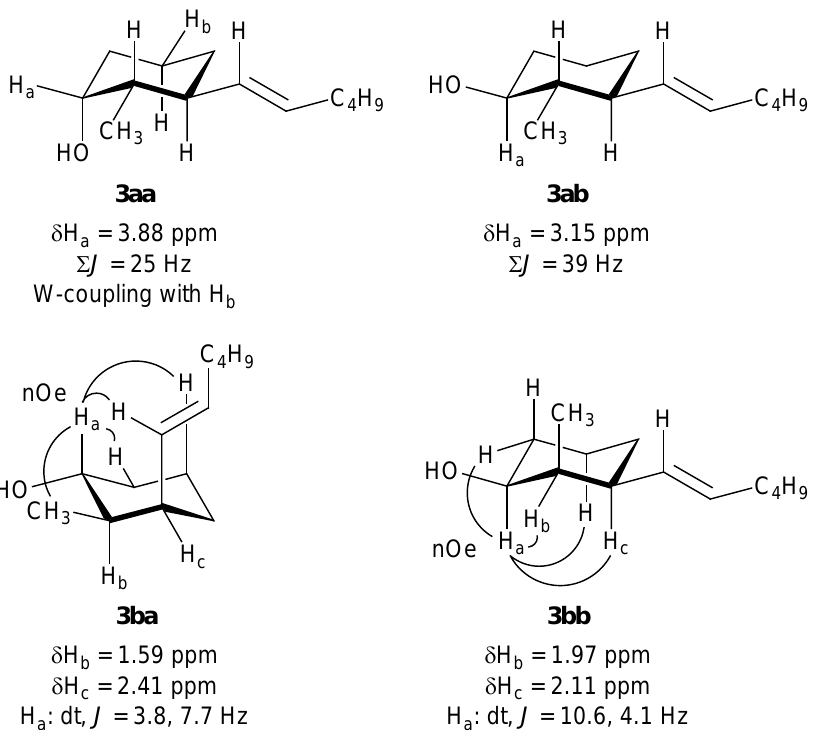
Figure 2. 1 H-NMR structural assignments of the intermediate alcohols 3aa , 3ab , 3ba , and 3bb